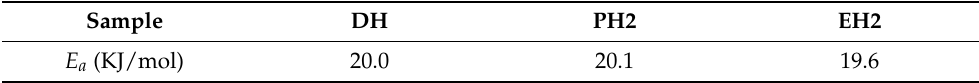
Table 3. The activation energy for the hydrogenation of DH, PH2 , and EH2 .